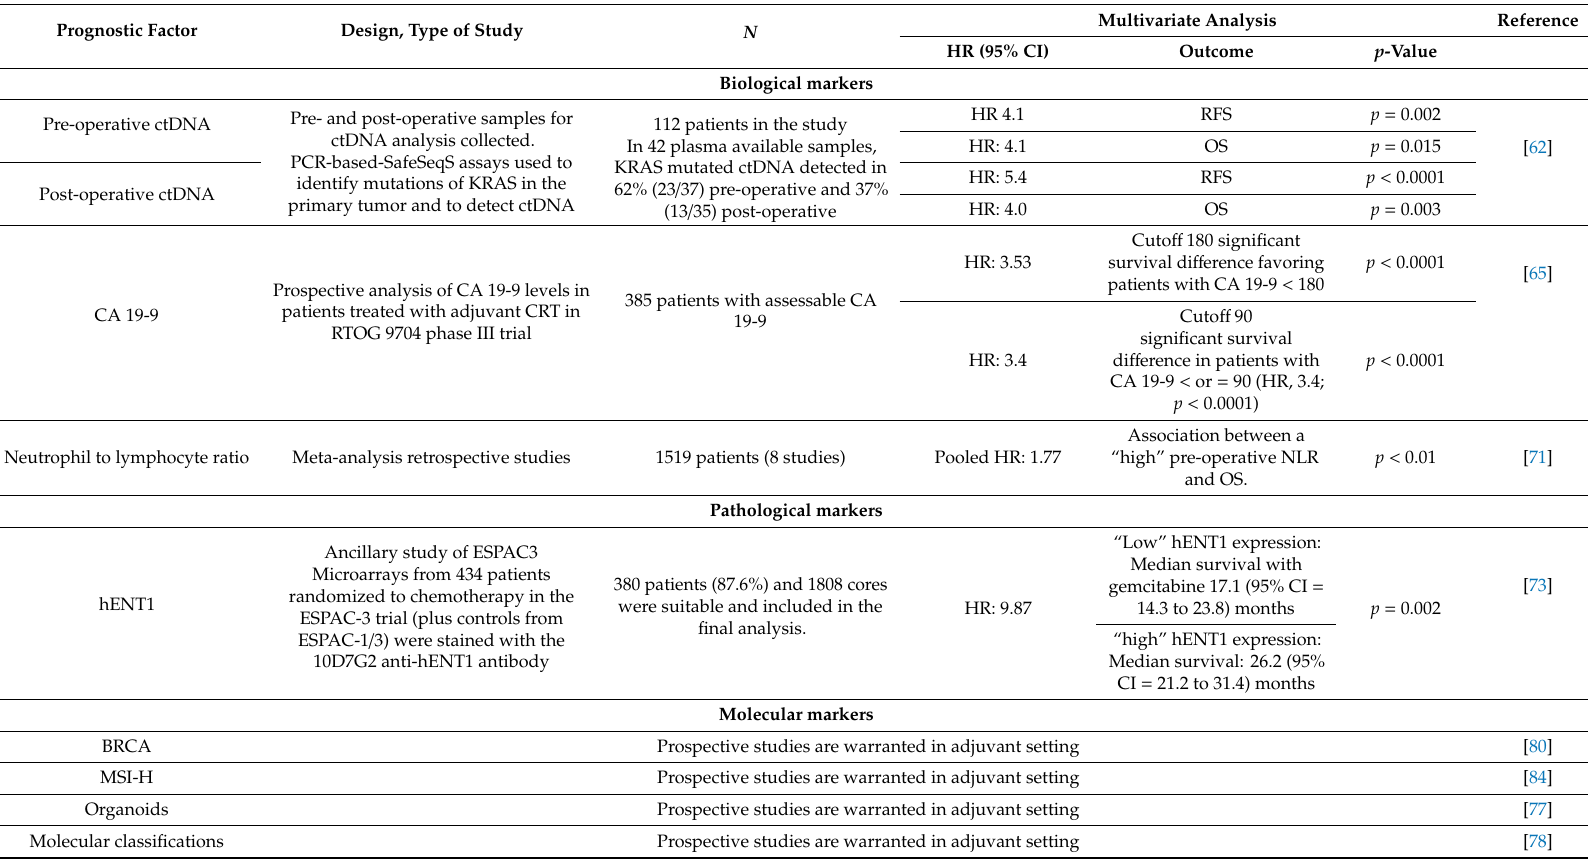
Table 4. Promising biomarkers of adjuvant chemotherapy after pancreatic surgery, evaluated in prospective studies. Prognostic